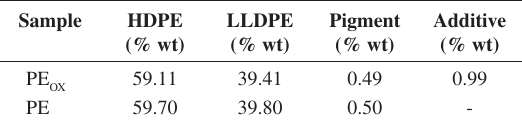
Table 1. Formulation of polymeric